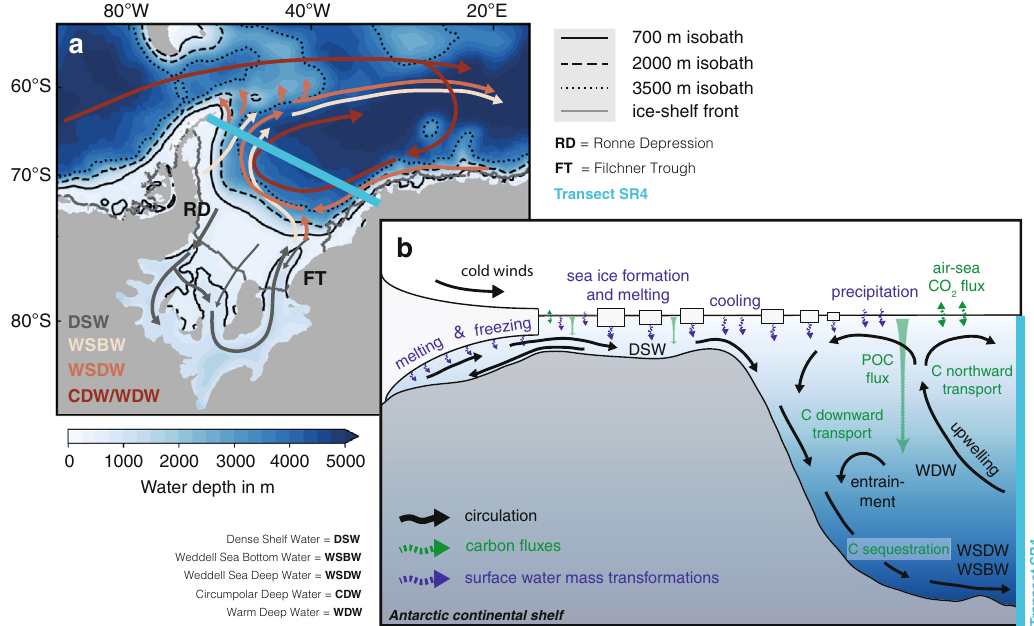
Fig. 1 Sketch illustrating the major processes involved. a Water depth in m below the ocean surface in the Weddell Sea and a schematic view of the general two-dimensional circulation in the area, adapted from ref. 9 . The transect SR4 of the World Ocean Circulation Experiment is marked in mint, and different water masses are distinguished by colors. b Typical section from the Antarctic continent to the transect SR4, with general features of the overturning circulation sketched in black, adapted from refs. 1,9 . Highlighted in blue are surface water mass transformations by buoyancy fl uxes, and carbon fl uxes are marked in green. CDW Circumpolar Deep Water, WDW Warm Deep Water, WSDW Weddell Sea Deep Water, WSBW Weddell Sea Bottom Water, DSW Dense Shelf Water, POC particulate organic